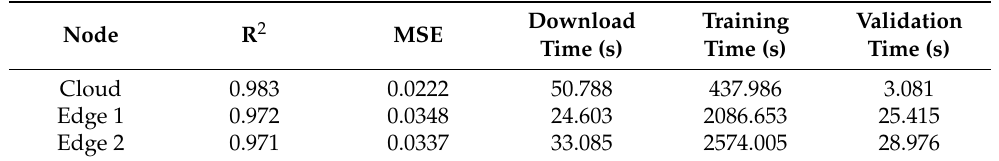
Table 6. Training time and validation results.